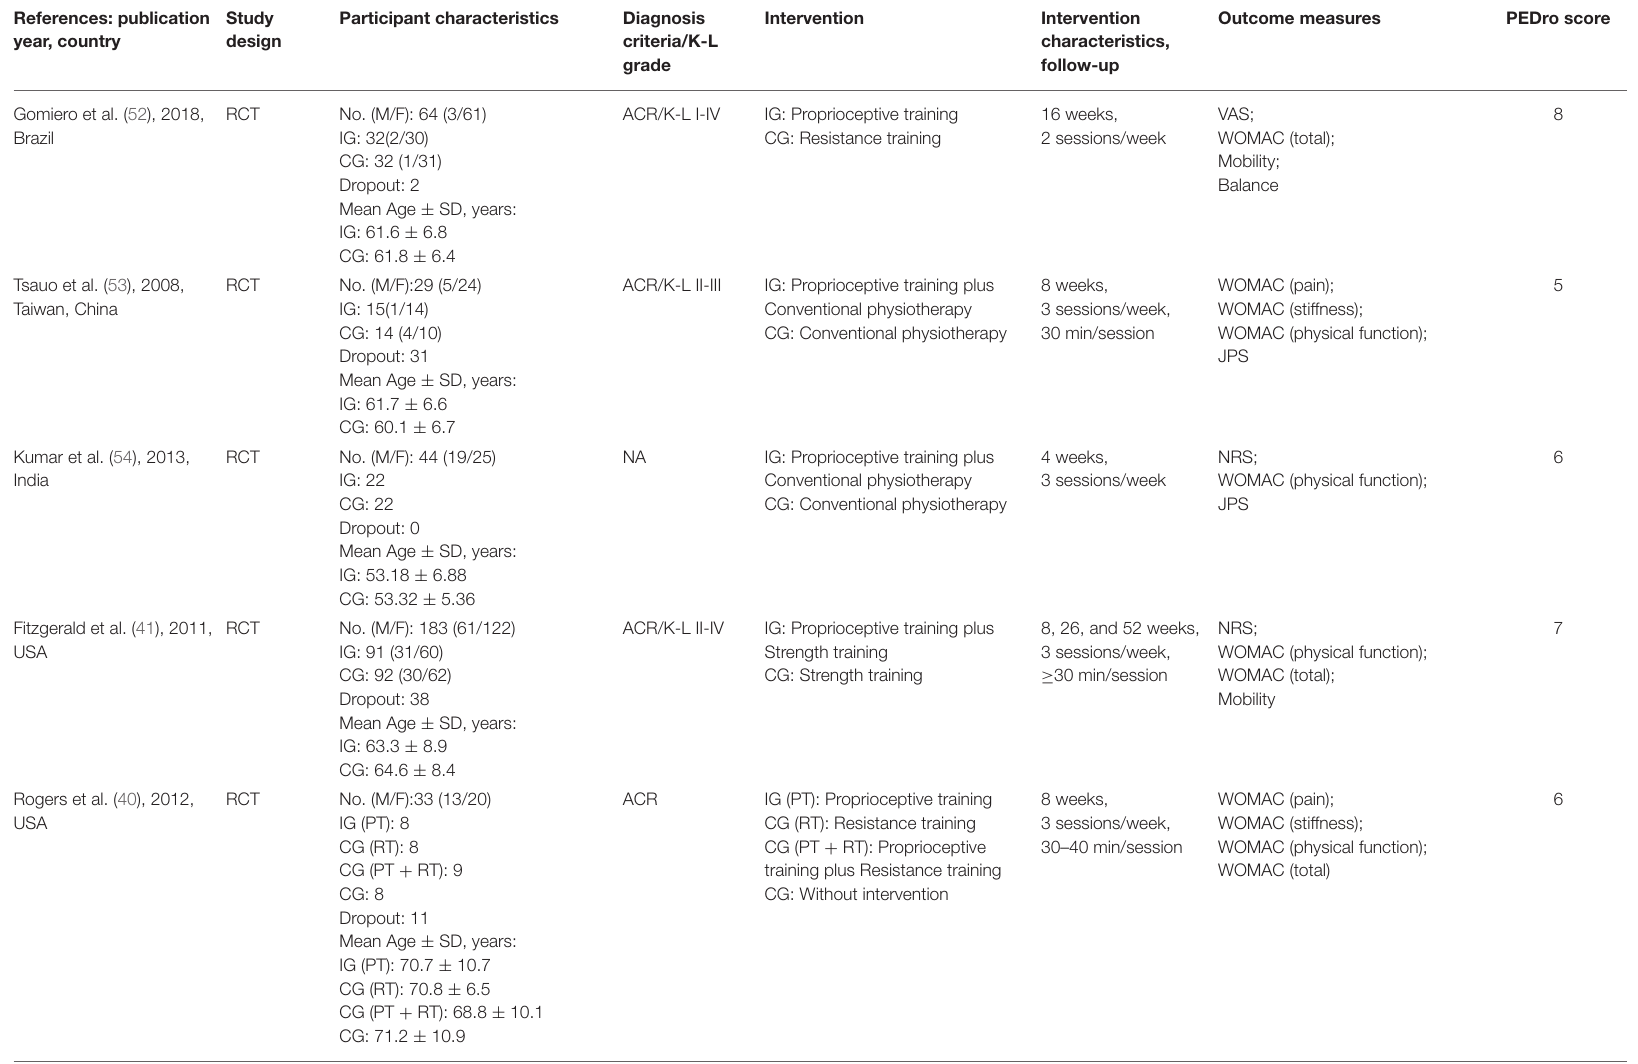
TABLE 1 | Characteristics of the included